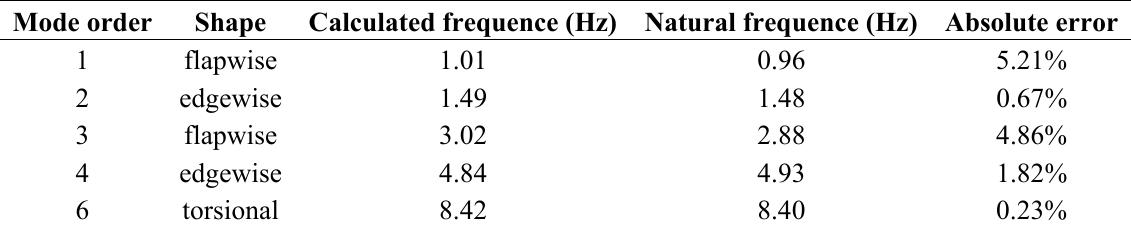
Table 3. Comparison between calculated and natural frequencies.